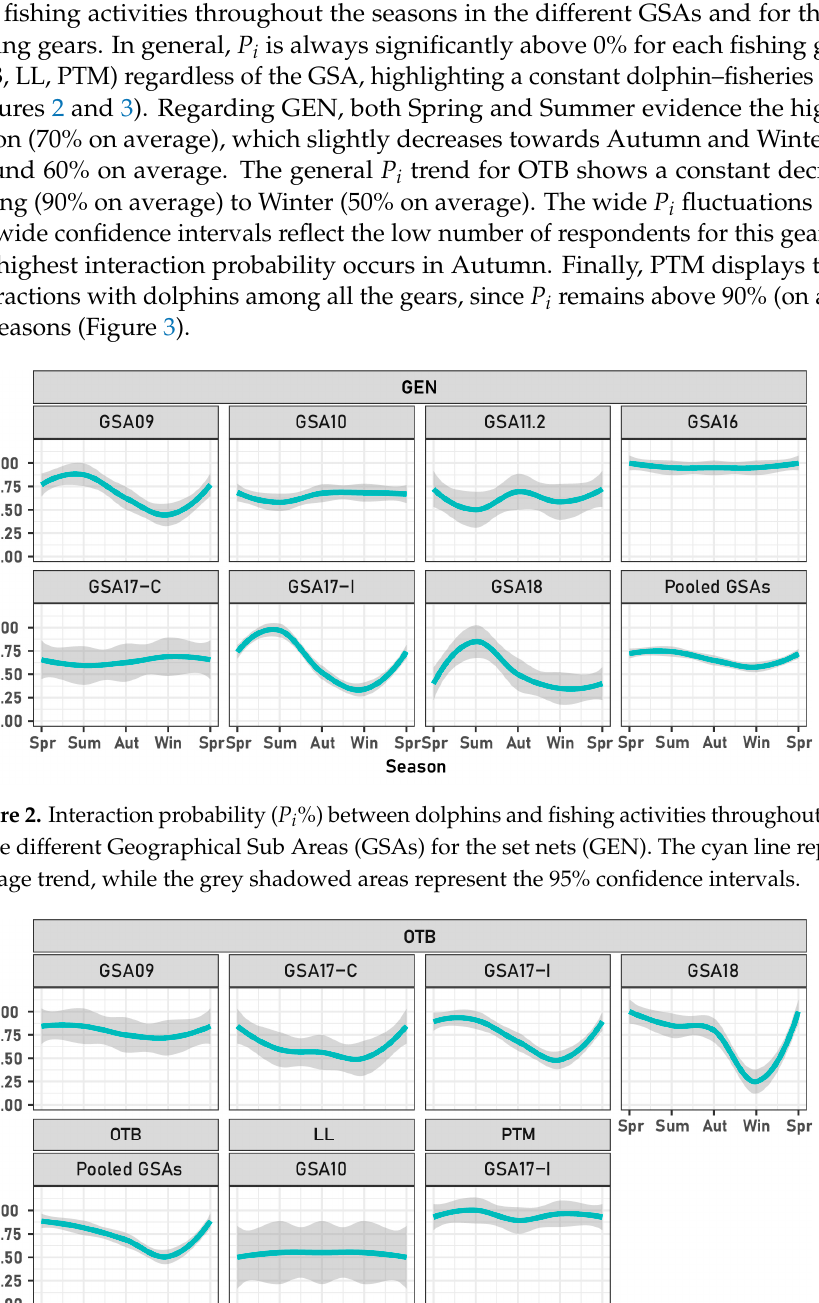
Figure 3. Interaction probability ( P i %) between dolphins and fishing activities throughout the seasons in the different Geographical Sub Areas (GSAs) and for bottom trawl (OTB), longline (LL), and midwater pair trawl (PTM). The cyan line represents the average trend, while the grey shadowed areas represent the 95% confidence intervals.